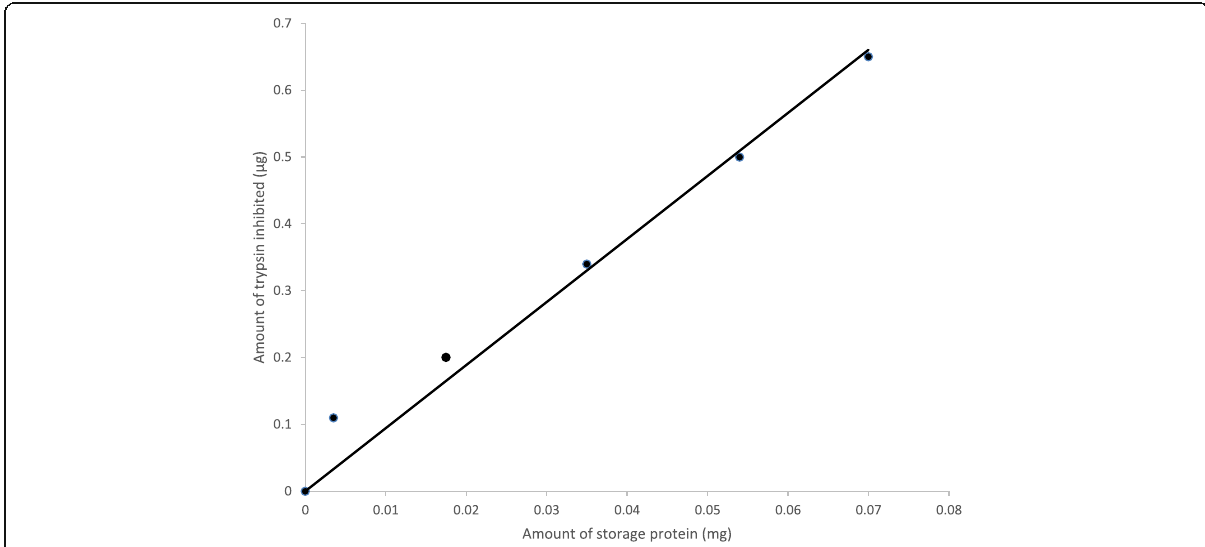
Fig. 5 Trypsin inhibitory activity of the major storage protein of the aerial tuber of D.